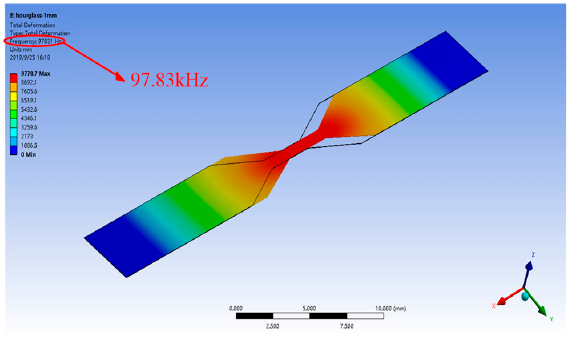
Figure 3. Resonant frequency determined by the finite element method (FEM) analysis.